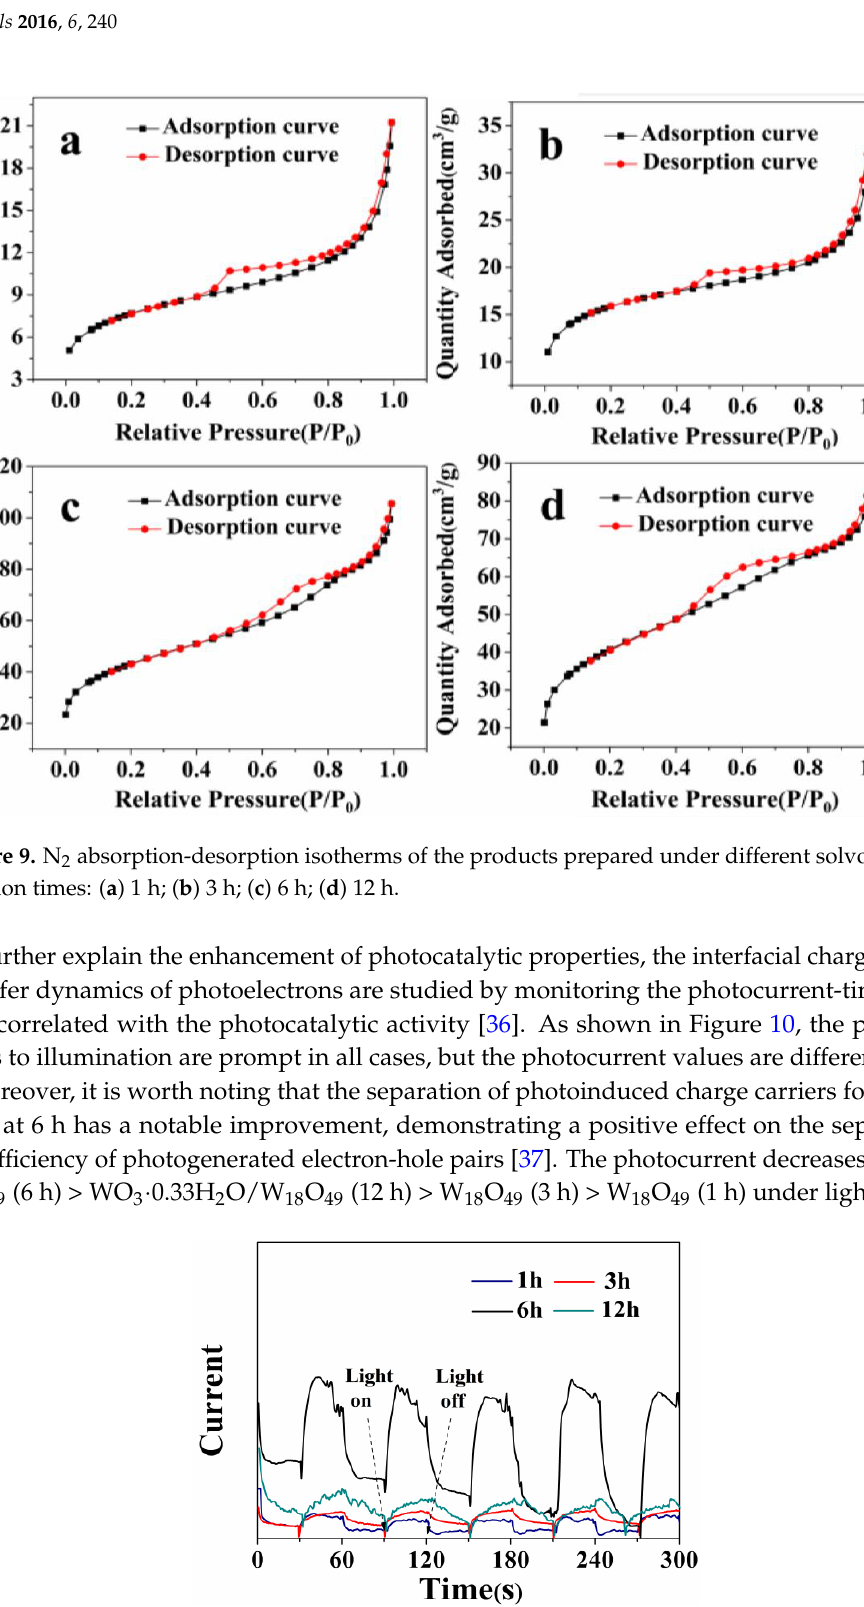
Figure 10. Photocurrent response of the products prepared under different solvothermal reaction